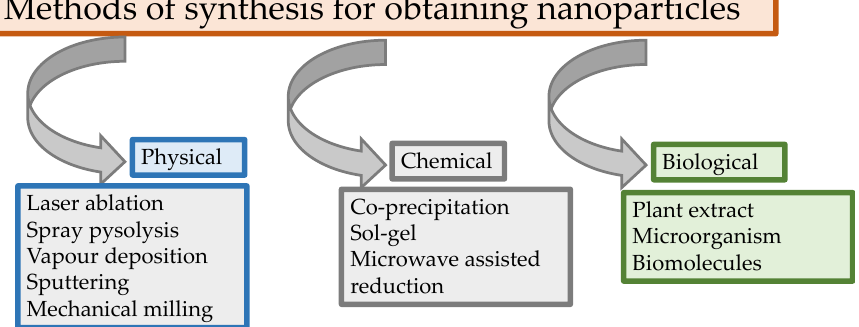
Figure 4. Methods of synthesis for obtaining nanoparticles.